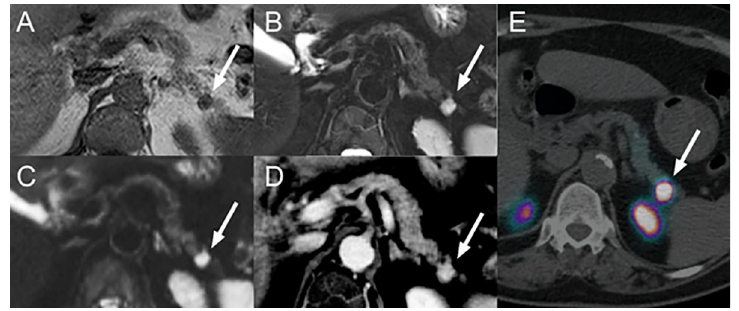
Fig 4. Imaging example of a small PICT with typical signal characteristics. PICT localized in the pancreatic tail (white arrow): hypointense on in-phase T1w (A), hyperintense on T2w fs T2w BLADE (B), hyperintense on DWI b- value 800 s/mm 2 (C) and hyperenhancing on ce T1w Dixon VIBE (D). 68 Ga-DOTA-exendin-4 PET/CT (E) confirming the lesion.